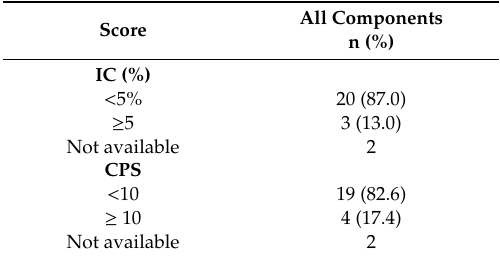
Table 4. Immunohistochemical evaluation of PD-L1 status (cut-o ff levels set according to current FDA / EMA